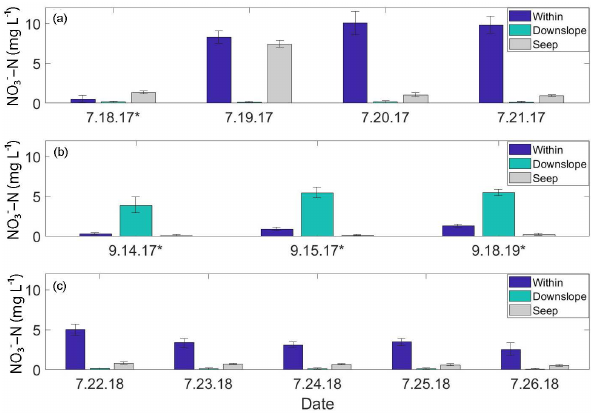
Figure 3. Soil pore water NO 3 -N time-series plots from the A1 tran- sect. “Within” and “Downslope” denote sample locations within and downslope of shrublands along the transect; “Seep” denotes a seep in the ground located on the A1 transect at the transi- tion between upland and lowland. Standard deviations are dis- played as black brackets on each bar. (a) July 2017 daily NO 3 -N concentrations. (b) September 2017 daily NO 3 -N concentrations. (c) July 2018 daily NO 3 -N concentrations. Days marked with an asterisk (*) indicate precipitation